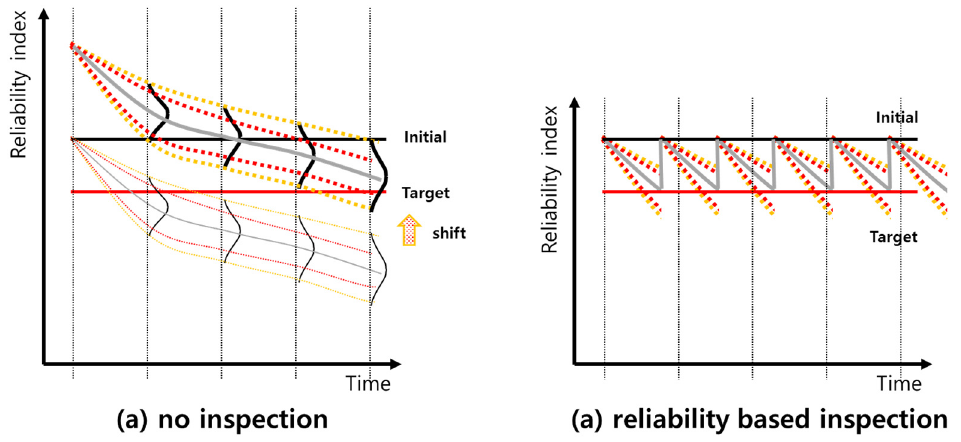
Figure 12. Reliability-based corrosion allowance and inspection; ( a ) no inspection case; ( b ) inspection case.